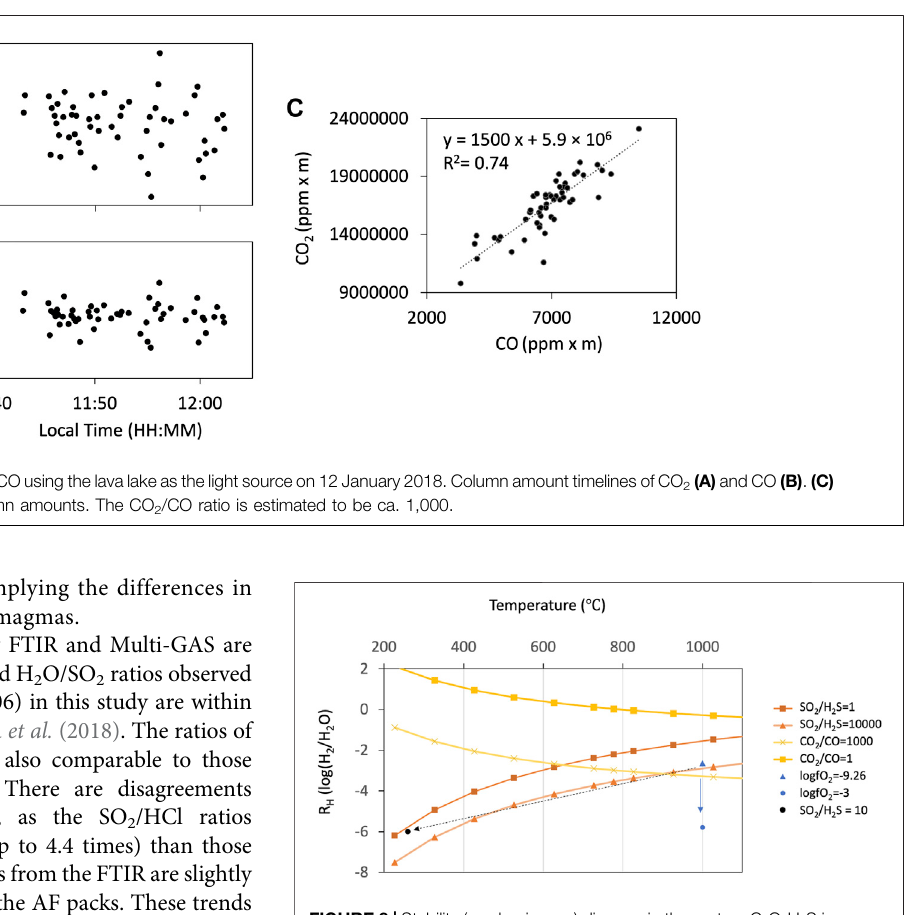
FIGURE 8 | Stability (predominance) diagram in the system C-O-H-S in terms of R H and equilibrium temperature. Variations of R H as a function of temperature at a fi xed fO 2 , SO 2 /H 2 S ratio, and CO 2 /CO ratio are shown. The two orange lines represent Giggenbach ’ s gas buffer lines where SO 2 / H 2 S ratios are 1 and 10,000 (Giggenbach, 1987). The two yellow lines represent stability lines where CO 2 /CO ratios are 1 and 1,000. Two blue dots represent stability points where log fO 2 values are − 9.26 and − 3 at 1,000 ° C. The former corresponds to the calculation value from iron speciation (deMoor et al. (2013)). The latter corresponds to several percent mixing with the atmospheric air (Martin et al., 2006) that could explain the R H value of − 6